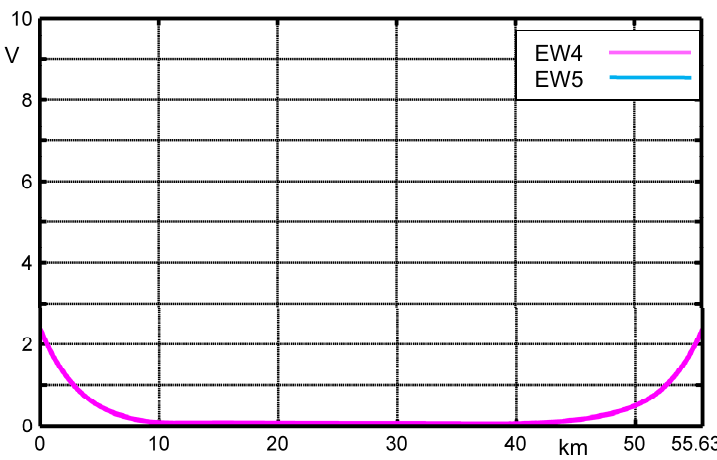
Figure 8. Earth wire voltage magnitudes along the OHL.